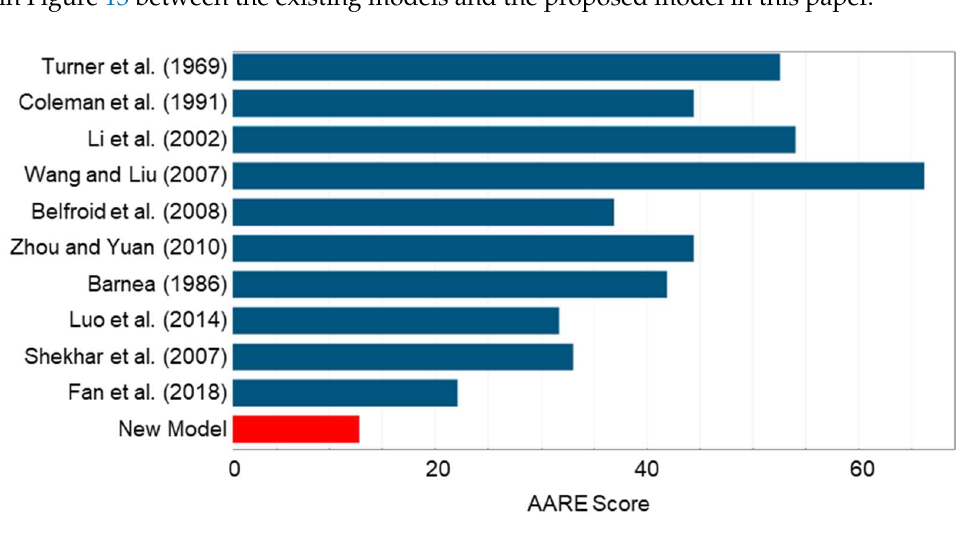
Figure 13. Average absolute relative error for different model predictions of critical gas velocity.